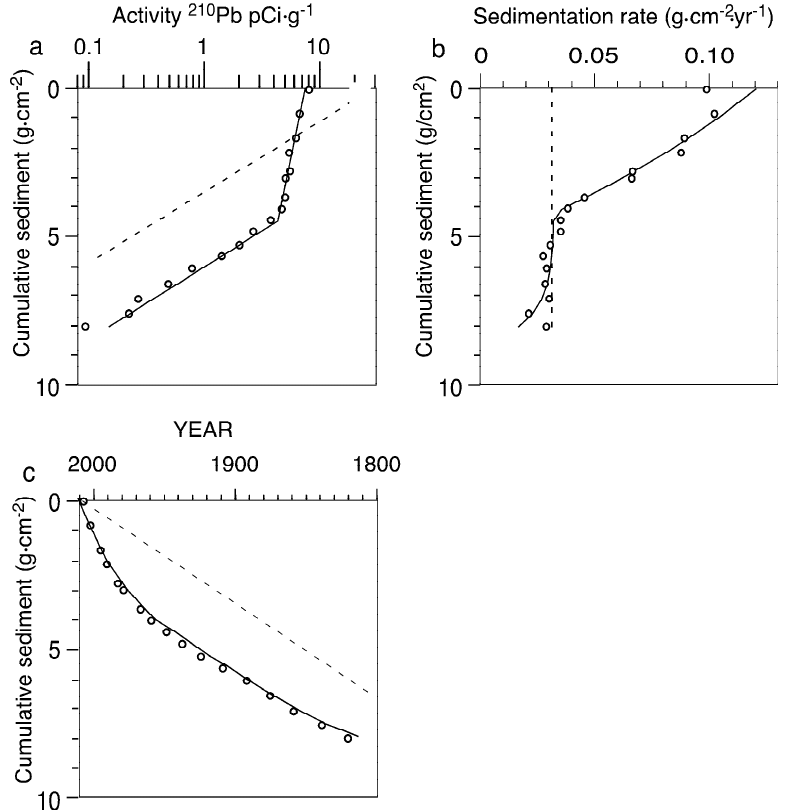
Figure 7. For each figure open circles represent original data for Lake West Okoboji [9]. Solid lines represent modeled values assuming sediment mixing. Dashed lines represent modeled values assuming no sediment mixing. ( a ) Unsupported activity of 210 Pb versus cumulative mass of sediments from the surface. ( b ) Calculated sedimentation rates versus cumulative mass of sediments from the surface. ( c ) Calculated years versus cumulative mass of sediments from the surface.